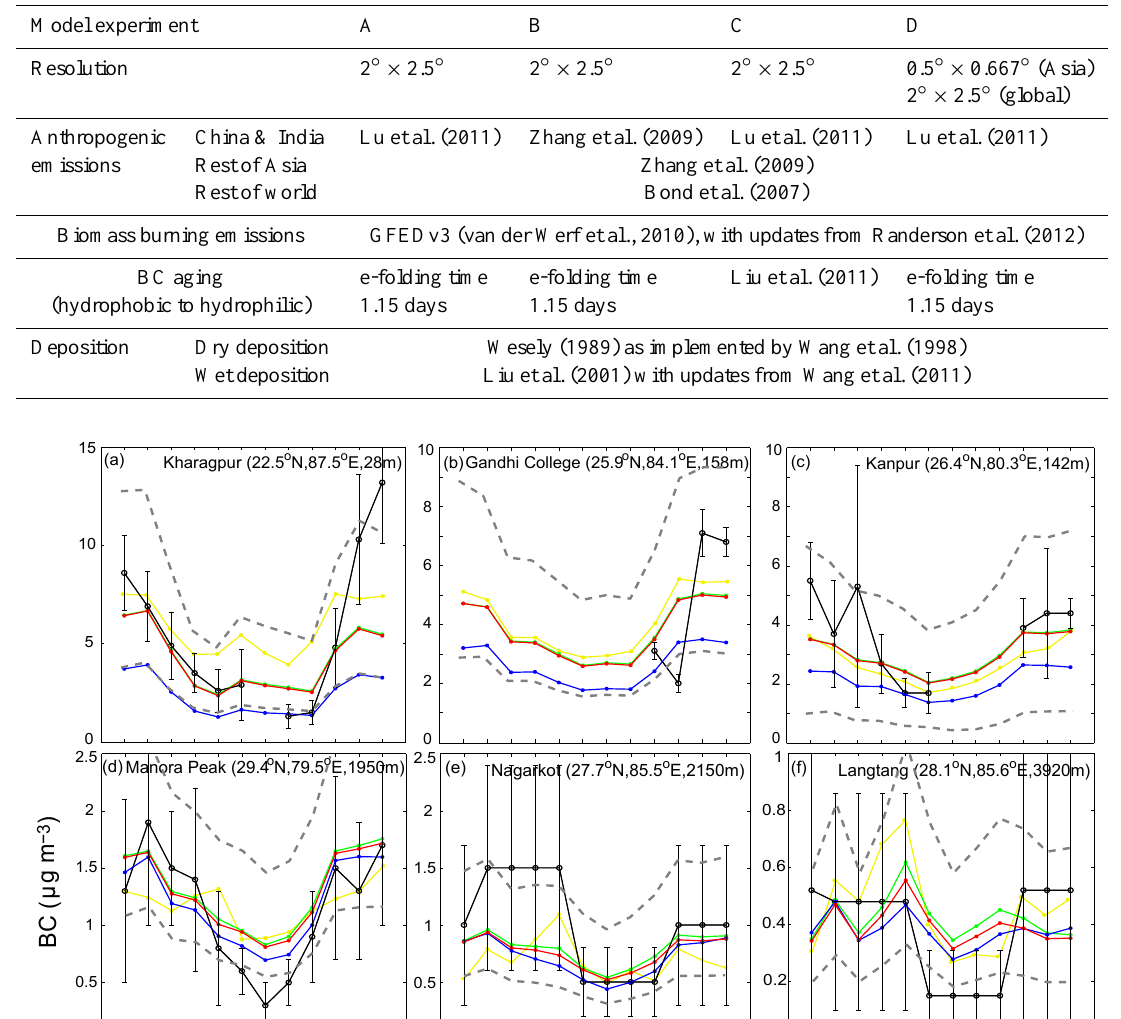
Table 5. GEOS-Chem simulations of BC.